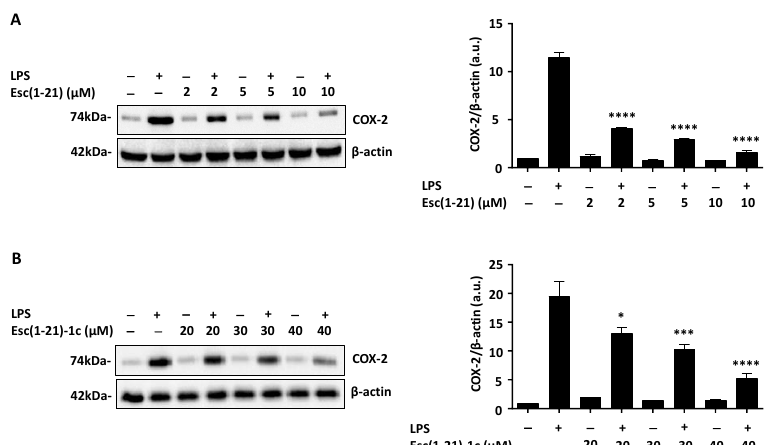
Figure 3. Effect of Esc(1-21) ( A ) or Esc(1-21)-1c ( B ) on COX-2 expression in LPS-stimulated RAW 264.7 macrophages. Cells were treated with P. aeruginosa LPS (20 ng/mL), peptides or LPS in combination with peptides as indicated, for 4 h. β -actin was used as loading control (cropped images). Samples we ran in the gels derive from the same experiment and were processed in parallel. Molecular weights of COX-2 and β -actin are also indicated. Full-length images are reported in Supplementary Figure S1. The right panels show quantitative analysis of COX-2/ β -actin ratio as measured by densitometry scanning using ImageJ software. Data are expressed in arbitrary units (a.u.) and are the mean ± SEM of three independent experiments. The level of statistical significance between samples treated with the LPS and those stimulated with the LPS plus peptide was determined by one-way ANOVA analysis and is indicated as follows: * p < 0.05; *** p < 0.001 and **** p < 0.0001.